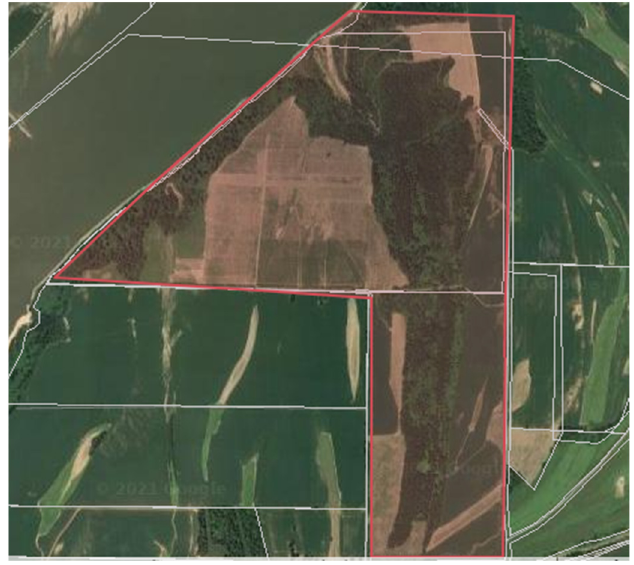
Figure 13 . Property in Hickman, KY [30,34] .